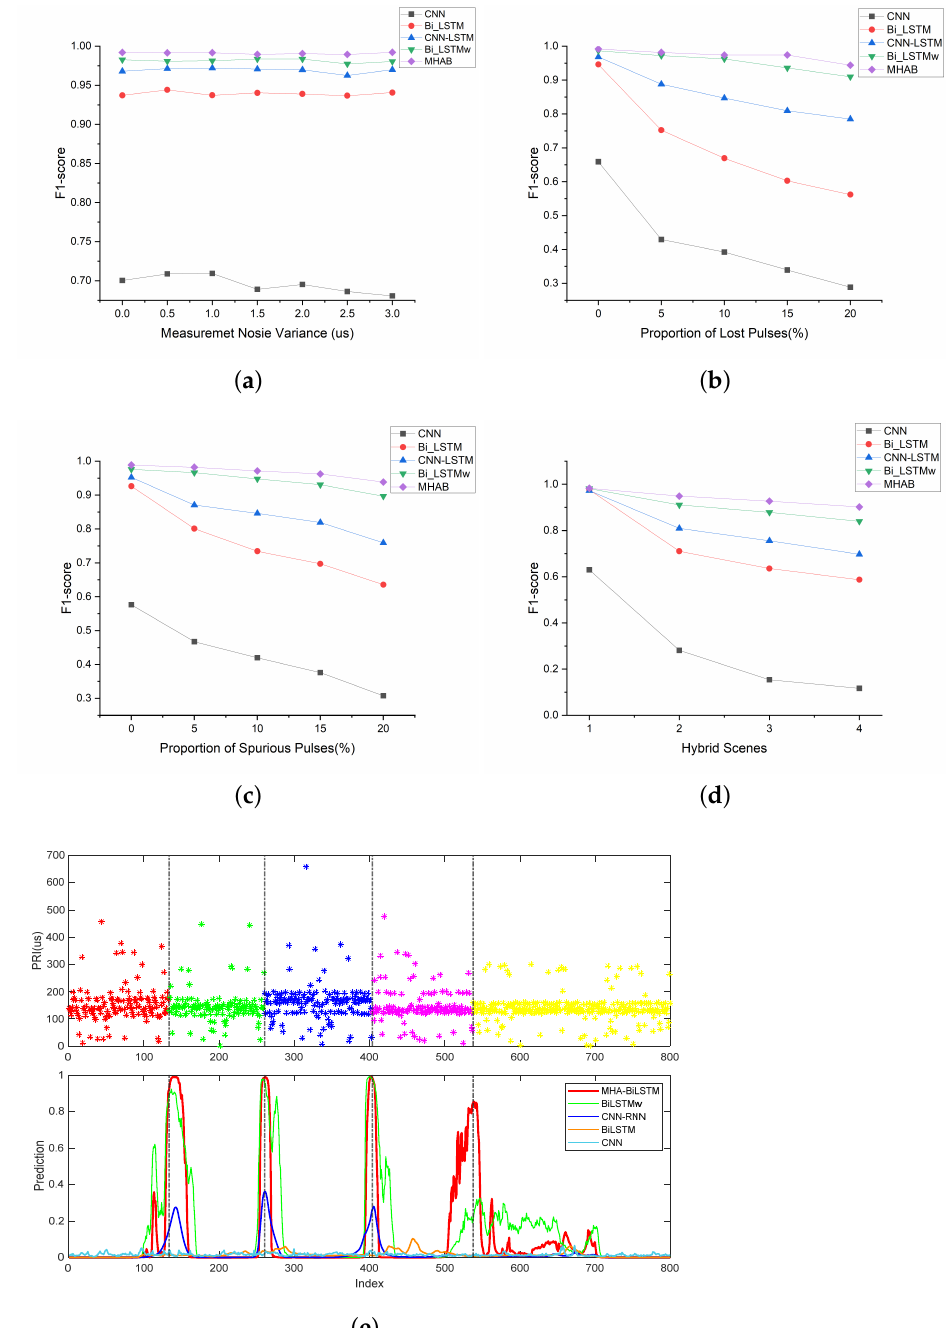
Figure 8. CPD performance under non-ideal conditions. ( a ) Under measurement noise conditions; ( b ) Under lost pulses conditions; ( c ) Under spurious pulses conditions; ( d ) Under hybrid non-ideal conditions; ( e ) A predicted result of a stagger PRI sequence in hybrid scene